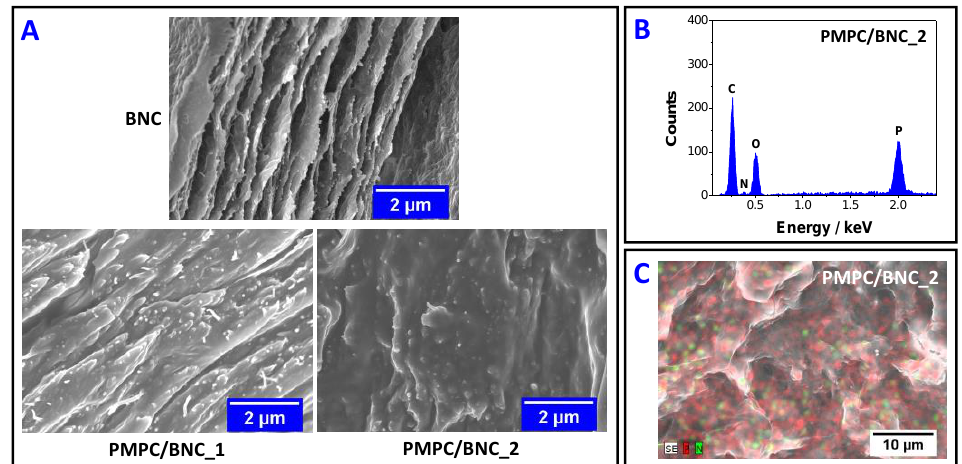
Figure 5. ( A ) SEM micrographs of the cross-section of neat BNC, and nanocomposites PMPC / BNC_1 and PMPC / BNC_2; EDS spectrum ( B ) and micrograph ( C ) for nitrogen and phosphorous elemental mapping of nanocomposite PMPC / BNC_2.